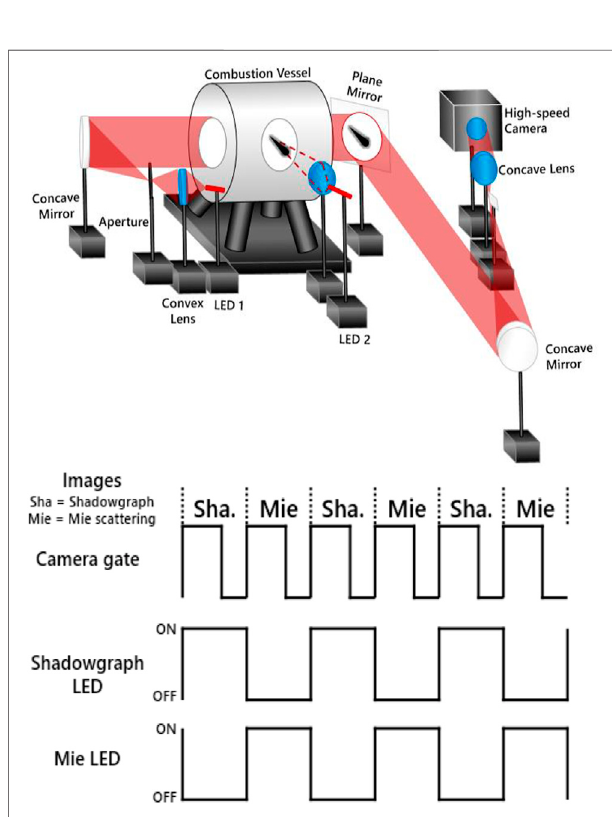
(2020), © SAE International.